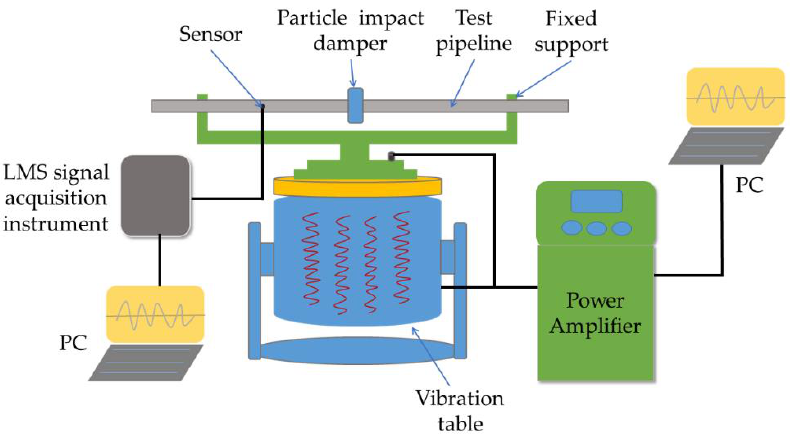
Figure 4. Schematic diagram of the vibration damping test system.